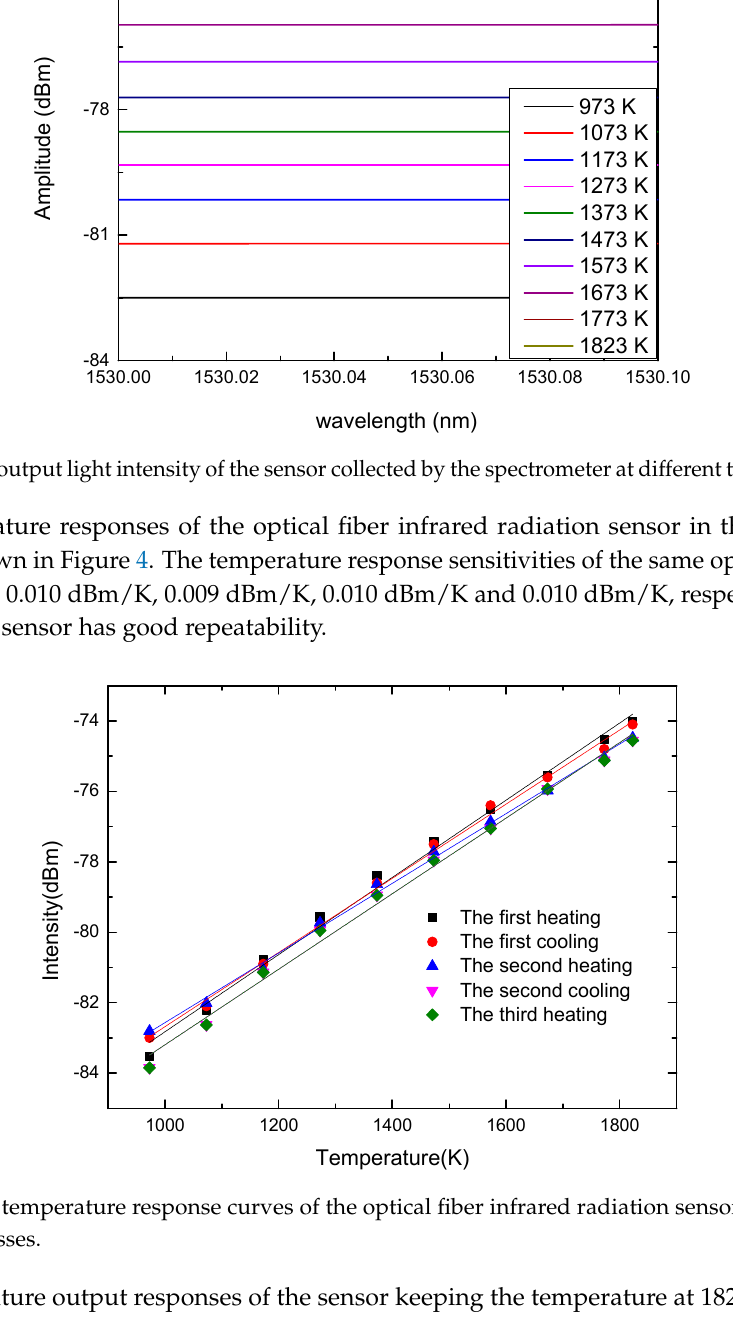
Figure 3. The output light intensity of the sensor collected by the spectrometer at different temperatures.